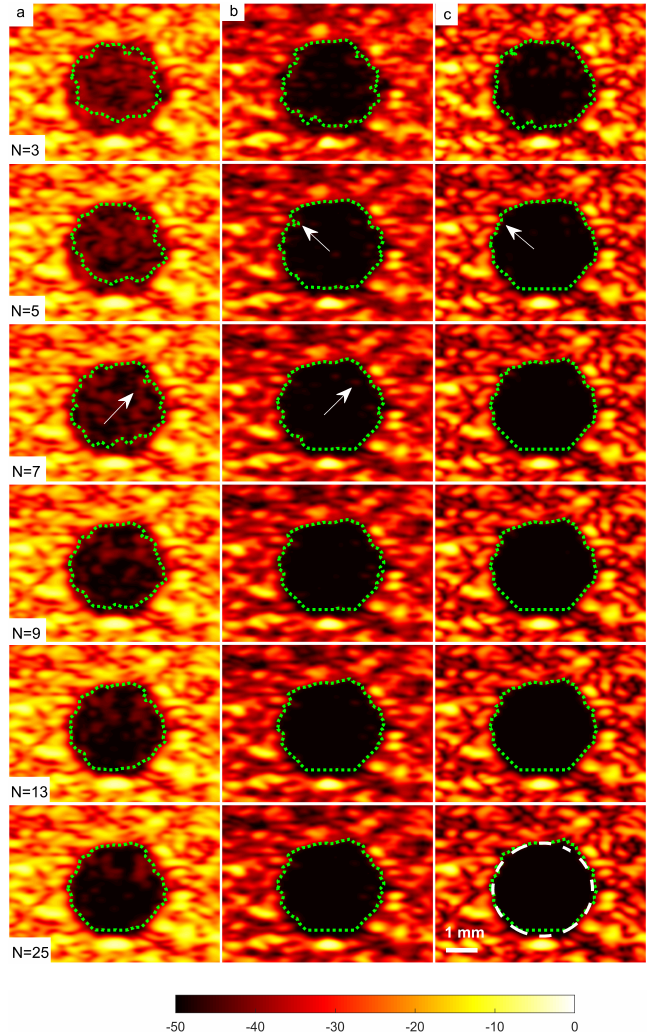
Figure 15. A set of B-mode images for a cyst with a diameter of 3.0 mm located at a depth of 15 mm using ( a ) DAS, ( b ) FDMAS and ( c ) DAS-FMAS with N = 3 to N = 25 steered plane waves. The green dashed line shows the BSAC implementation. The arrows on N = 5 images with FDMAS and DAS-FMAS highlight the side-lobe reduction, and in N = 7 images highlight the clutter noise with DAS and FDMAS that is no longer present inside the cyst with DAS-FMAS. The white dashed circle on ( c ), N = 25, shows the segmentation ground truth for the 3.0 mm diameter cyst to calculate the Dice coefficient and